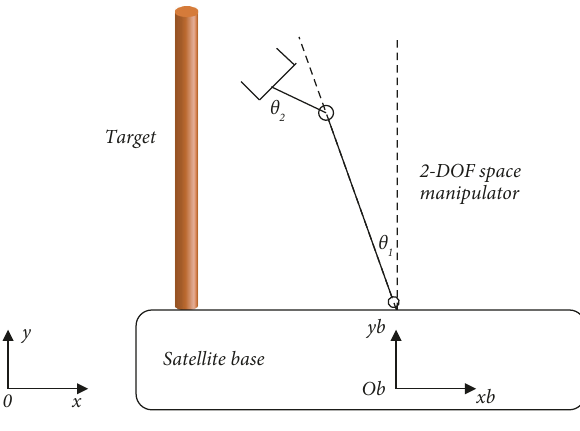
Figure 5: Two-degree-of-freedom robotic arm